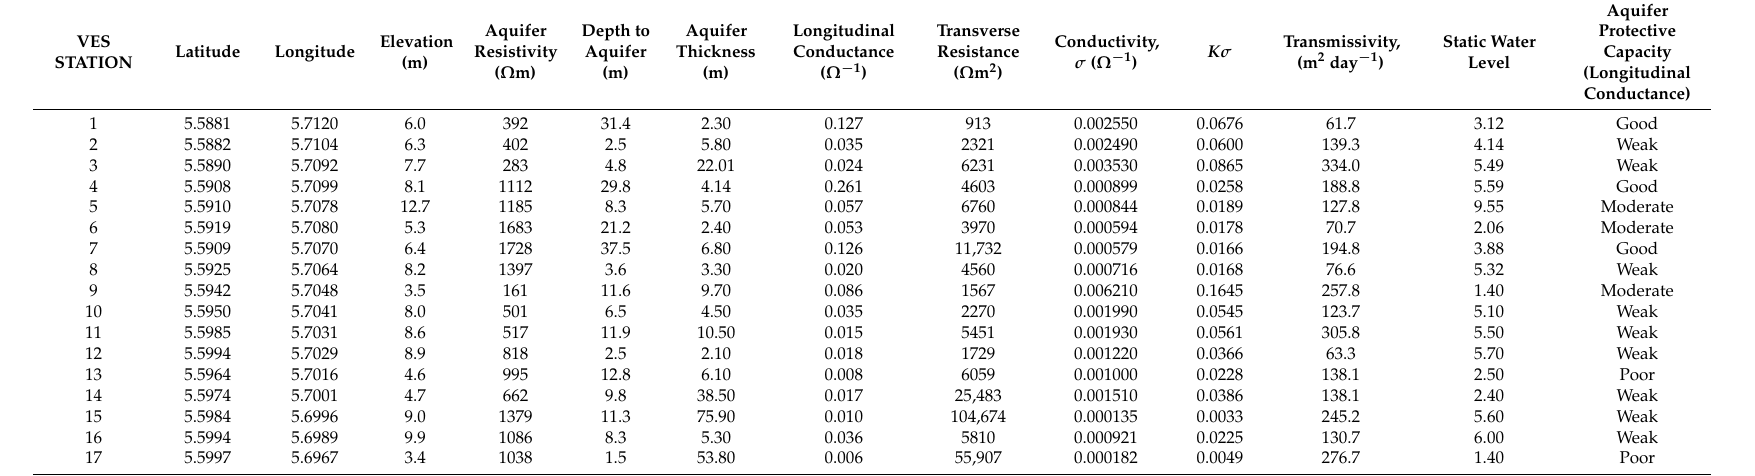
Table 2. Aquifer characteristics of the VES station in the study